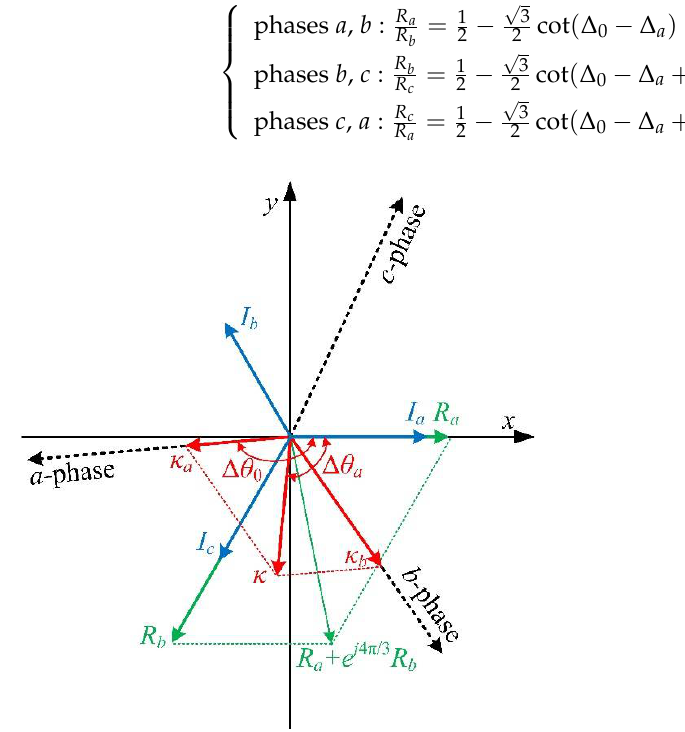
 . Figure 1. Decomposition mode of → κ v v